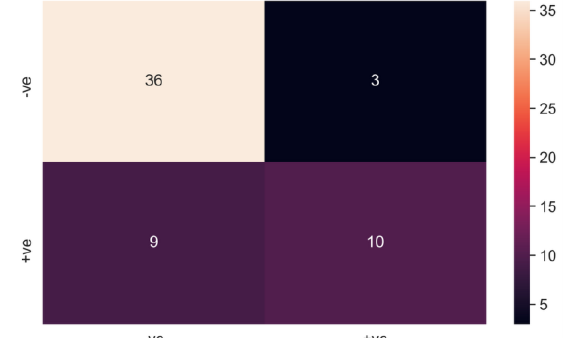
Figure 8. Performance of Bagging Trees